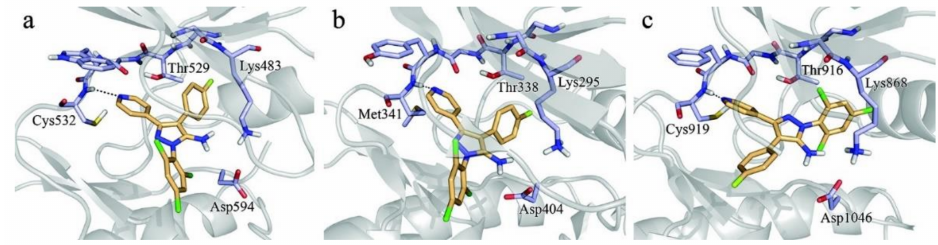
Figure 98. Putative binding interactions of compound 92 with B-RAF ( a ), Src ( b ), and VEGFR2 ( c ) [103].